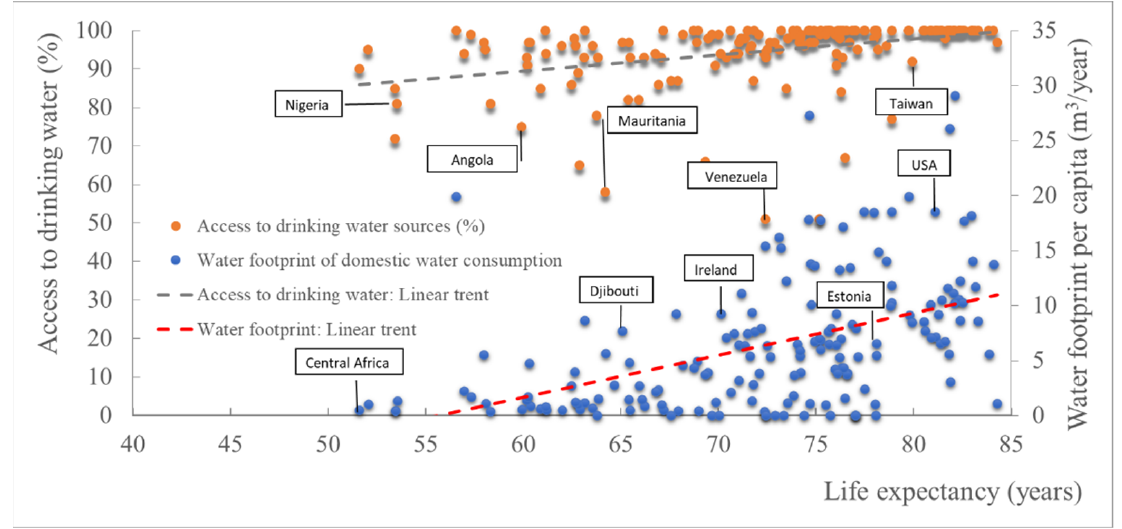
Figure 4. Life expectancy related to access to drinking water [21], and the annual water footprint of the consumption of domestic blue water per capita (1996–2005) [6,22,23].